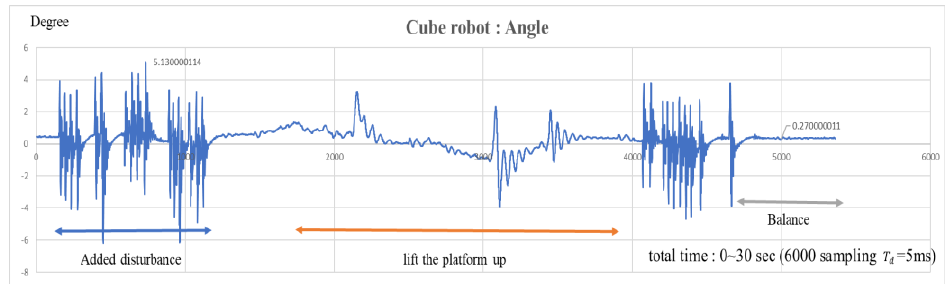
Figure 15. Time response of the tilt angle 𝜃 𝑃 of the cube robot balancing on its edge.